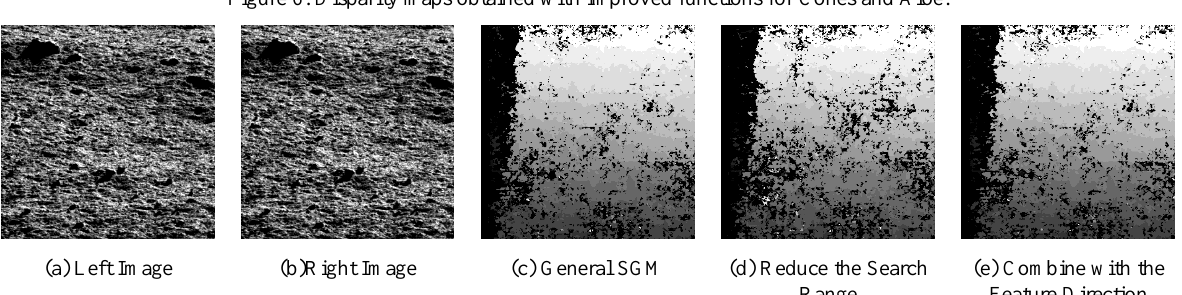
Figure 6. Disparity maps obtained with improved functions for Cones and Aloe.